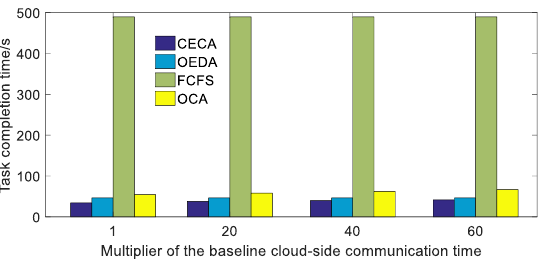
Figure 7. Impact of cloud-edge communication time on the completion time of tasks by different algorithms.